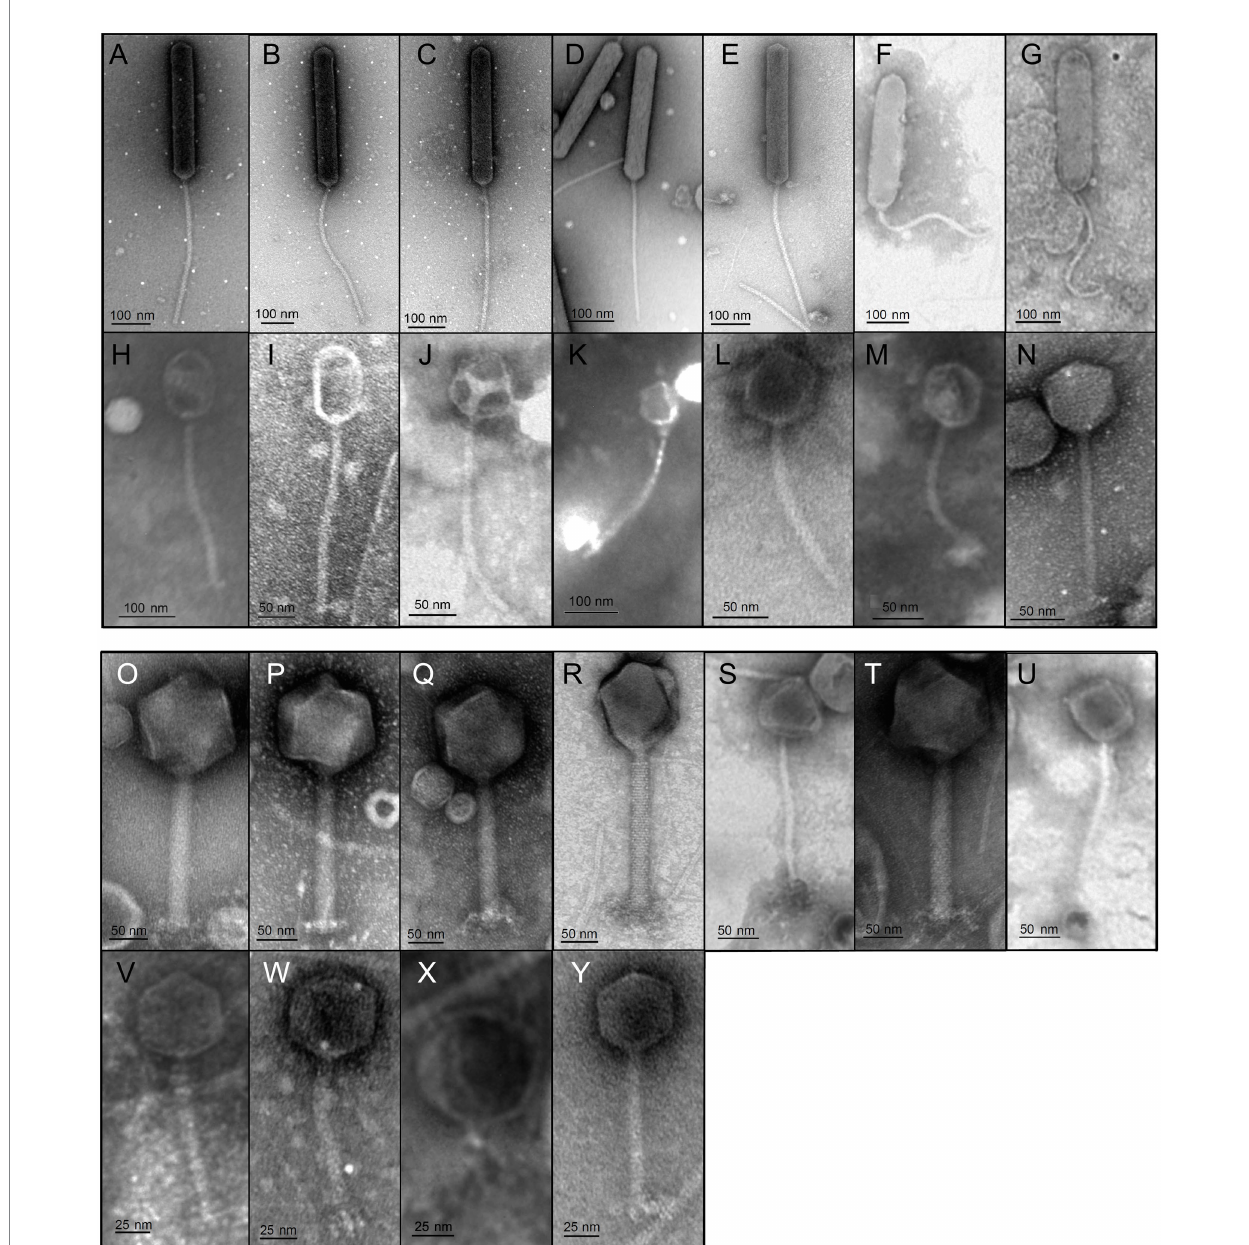
FIGURE 3 Transmission electron micrographs of all 25 isolates. Bacteriophage preparations were negatively stained with 2% (w/v) aqueous uranyl acetate. Samples were examined in a Joel 1011 transmission electron microscope. The scale bar represent 25 nm (V–Y) , 50 nm (I,J,L–U) and 100 nm (A–H,K)